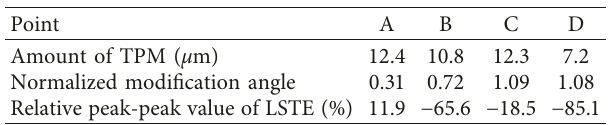
Figure 17: Dynamic tooth loads on external and internal meshes under different sun-gear speed effects of TPM applied in internal meshes (unit:%): (a) external meshes, (b) internal meshes at 3000rpm, (c) external meshes, and (d) internal meshes at 7500rpm. Table 3: Modification parameters and relative peak-peak value of the LSTE of the noted